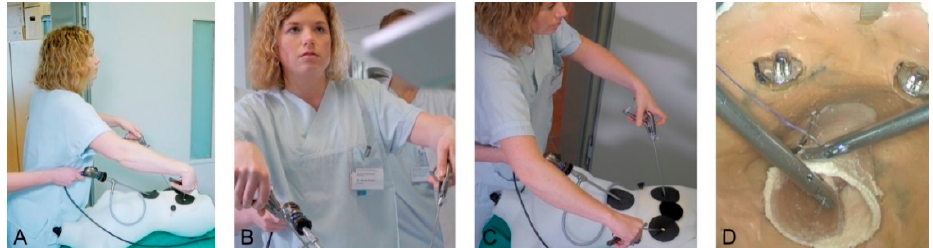
Figure 2. Four camera perspectives: posture ( A ), posture and instruments ( B , C ), and the surgical site ( D ).